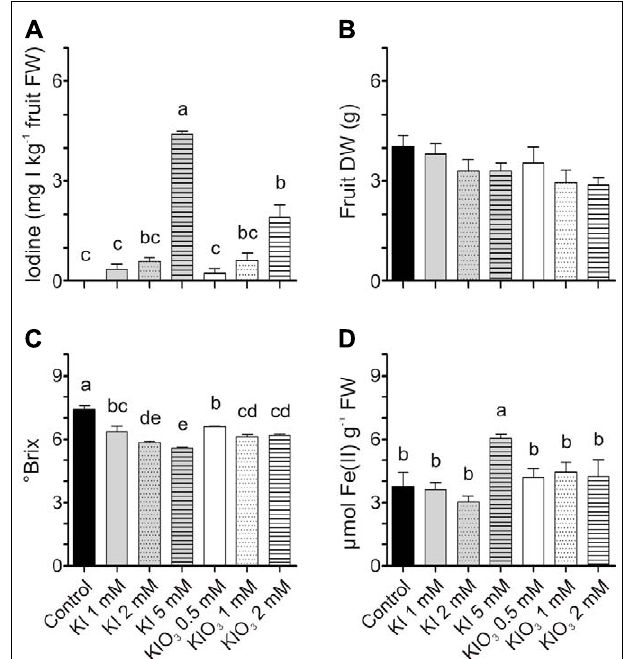
FIGURE 5 | Effects of shelf-life and cooking on iodine content of fruits. Fruits turning red at harvest for the shelf-life experiment (A) . Red fruits at harvest for the boiling experiment (B) . Iodine content in 5 mM KI-treated fruits at harvest, and after one or 2 weeks of storage at room temperature (C) . Iodine content in 5 mM KI-treated fruits at harvest not boiled (n.b.) or boiled (b.) with ( + P.) or without ( − P.) peel, or in fruit skin not boiled [P. (n.b.)] (D) . Data were subjected to one-way analysis of variance (ANOVA) and the means were separated using the F -test (95% confidence level).